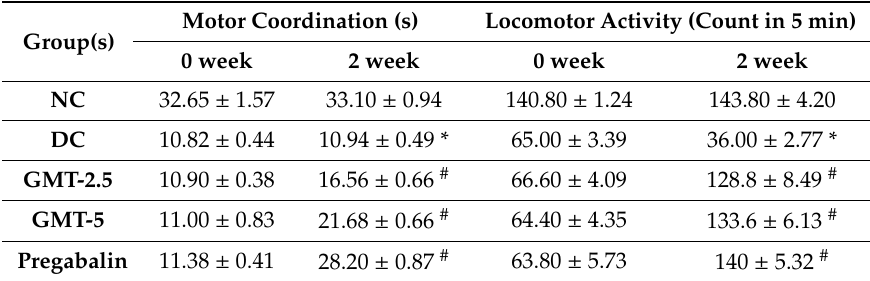
Table 5. E ff ect of chloroform extract of goat milk treated A. napellus on motor co- ordination and locomotor activity.